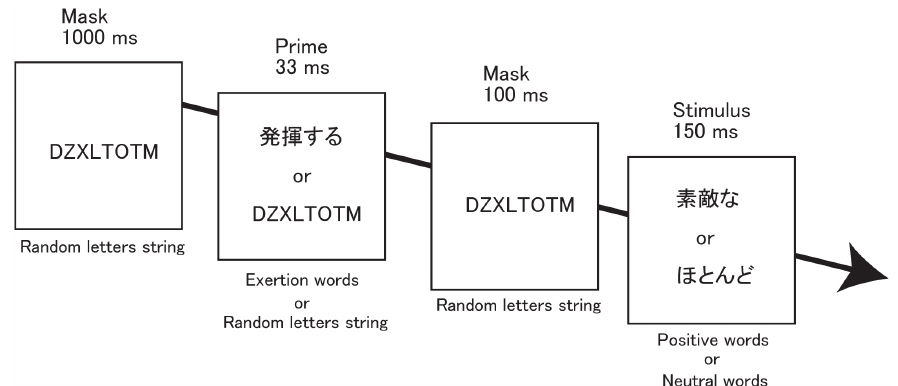
Figure 1. Priming procedure. In the priming-plus-reward condition, the subliminal barely visible exertion primes were always paired with positive words. In the priming condition, although exertion primes and positive words were both displayed, they were never paired with each other. In the control condition, subliminal barely visible exertion words were never displayed. The order of possible stimulus pairs was randomized within each condition. Exertion, positive, and neutral words were Japanese. Each trial in each condition began with a 1000-ms presentation of a random eight- letter string (e.g., DZXLTOTM) as a forward mask. This was followed by the subliminal barely visible prime, displayed for 33 ms. A random letter string was again displayed for 100 ms as a backward mask, after which a consciously visible word was presented for 150 ms. Occasionally, a dot was presented for 33 ms (it was visible because of the absence of a backward mask), either above or below the neutral or positive word.